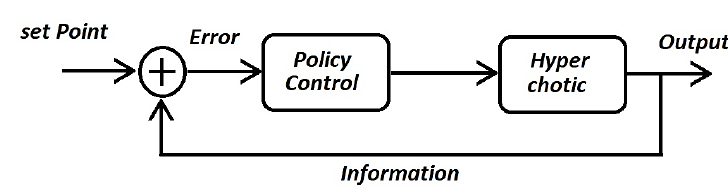
Fig. 5. Supply chain control policy for eliminate hyperchaotic